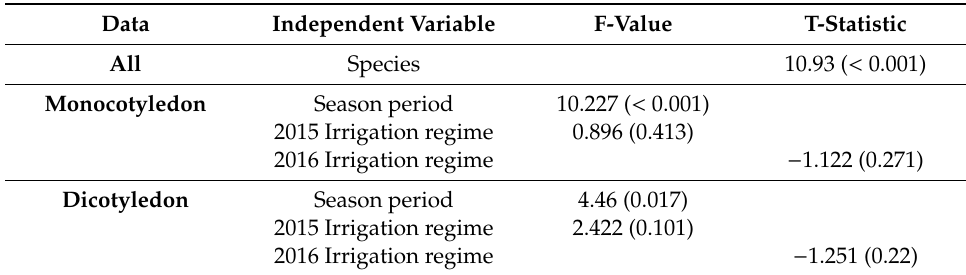
Table 3. Welch’s two-sample t-test and analysis of variance 1 .